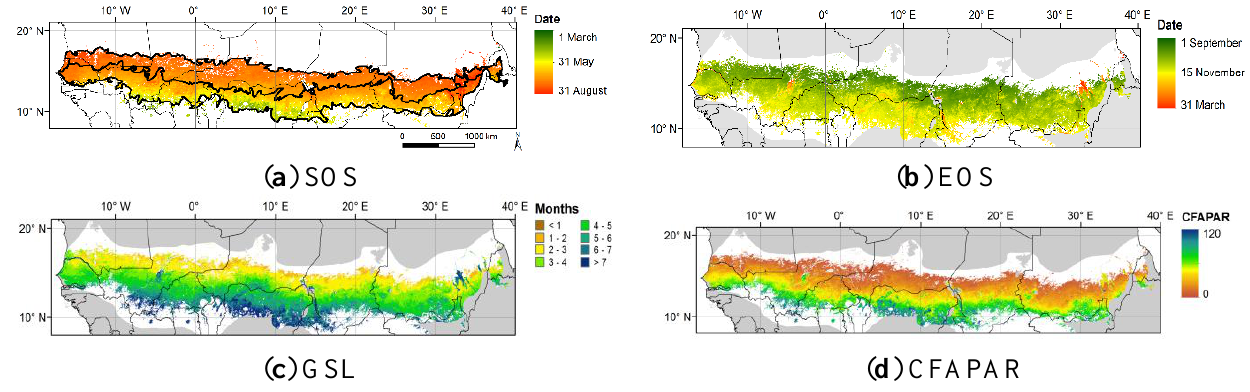
Figure 2. Average start (SOS) ( a ), end (EOS) ( b ) and length ( c ) of the growing season and the cumulative Fraction of Absorbed Photosynthetically Active Radiation (CFAPAR) value ( d ) during the growing season. Average values are computed over the set of phenological variables extracted from the FAPAR time series ( n = 15, years 1998–2012). Phenological variables and CFAPAR are shown for the herbaceous and cropland land covers (other classes in white) and the five main eco-regions of the Sahel (other regions in